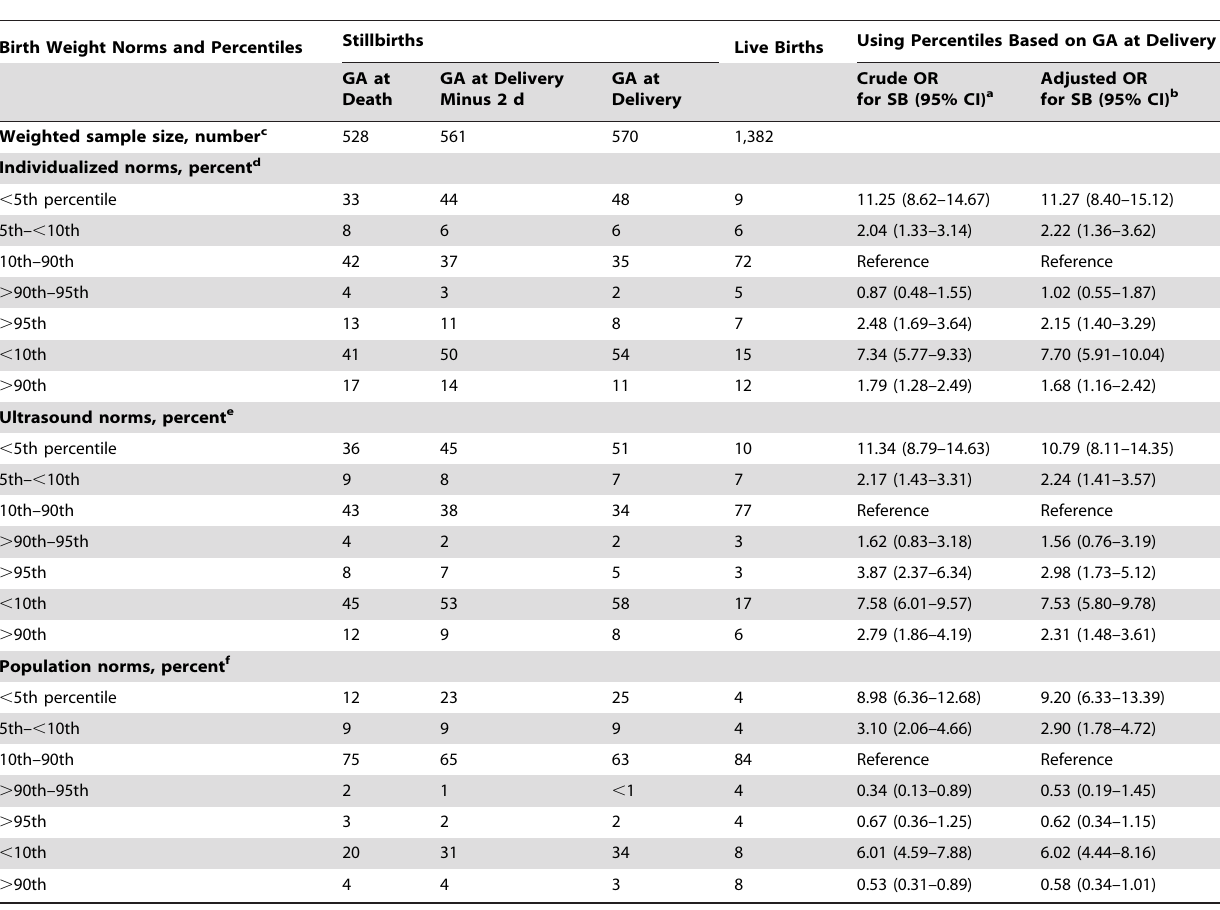
Table 6. Birth weight percentiles in relation to different GA estimates among singleton stillbirths.